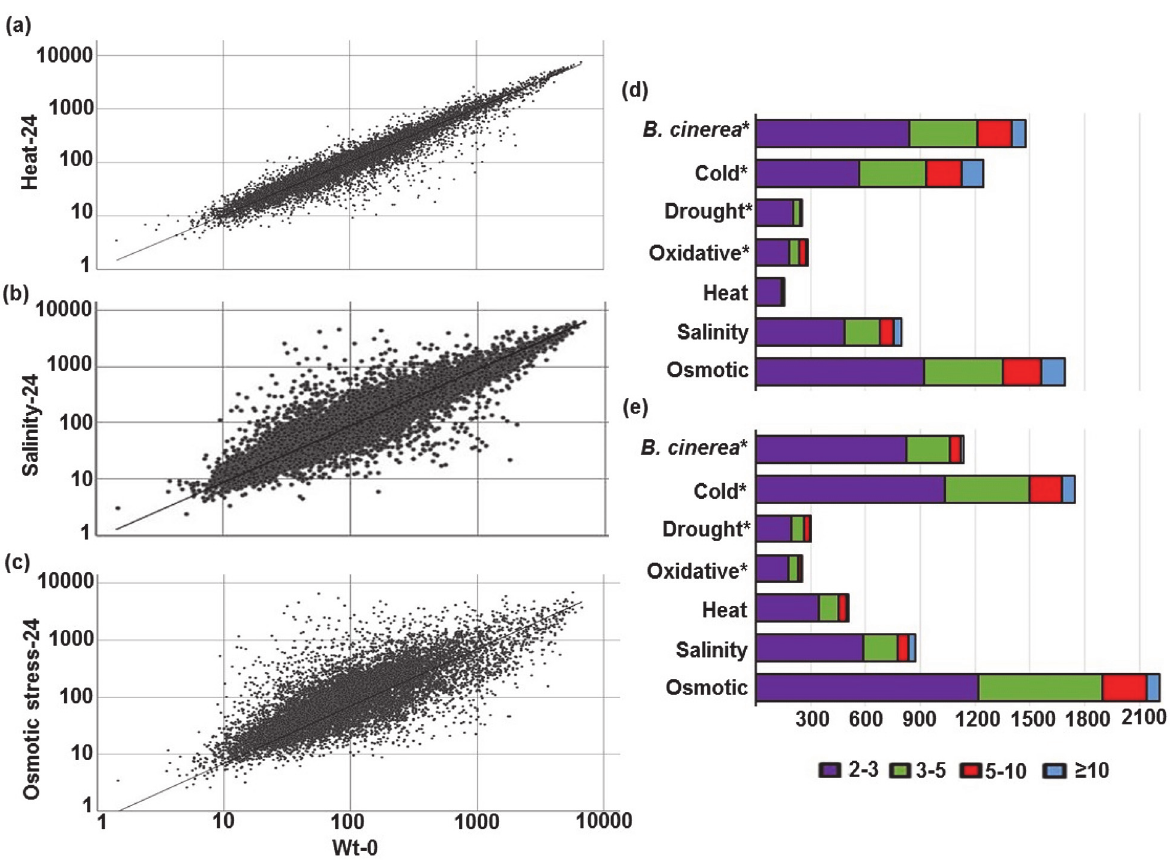
Fig 1. Comparisons of gene expression in Arabidopsis plants under biotic and abiotic stress conditions. Normalized expression values for each probe set in stressed plants with heat (A); salinity (B); or osmotic stress (C) at 24 hpt is plotted on the Y-axis. In (A-C), the value in wild-type plants sampled before the abiotic stress treatment (0 hpt; WT-0) is plotted on the X-axis. Number and the level of transcripts identified as upregulated (D), or downregulated (E) genes in Arabidopsis stressed plants. In (D-E), the treatment of the tested abiotic stress is plotted on the Y-axis; the number of differentially expressed genes is plotted on the X-axis. Columns with different colors show the fold change of corresponding differentially expressed genes. * Results were obtained from [20]. hpt, hours post treatment.